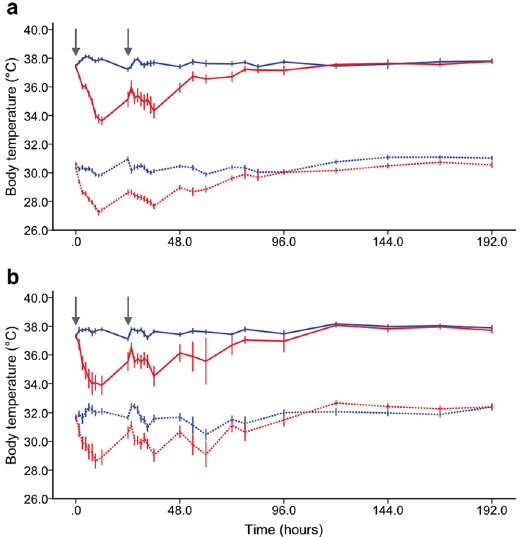
Figure 1. Line graphs showing body core and surface temperature across lipopolysaccharide (LPS)- and saline- treated groups for up to 7 days post-treatment. ( a ) Temperature profile obtained by implantable radio frequency identification (RFID) transponders and infrared thermometer 2 (n = 380; LPS-treated, 251; saline-treated, 129). ( b ) Temperature profile obtained by implantable RFID transponders and infrared thermometer 1 (n = 55; LPS-treated, 33; saline-treated, 22.). Blue, saline-treated control animals; red, LPS-treated animals; solid line, core temperature; dotted line, surface temperature; grey arrow, time of LPS/saline injections. Data shown are means ± 95%